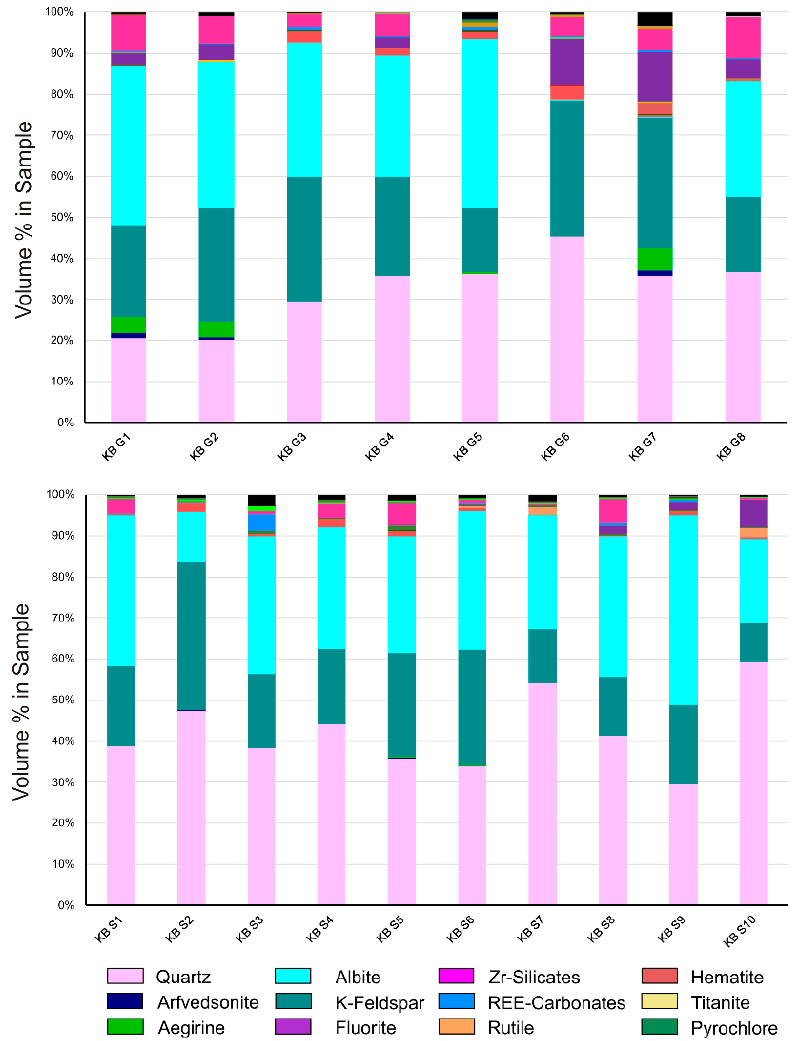
Figure 2. Modal composition (vol. %) of samples from ore bearing metasomatites in sampling areas KB G ( top ) and KB S ( bottom ), calculated from mineralogical phase maps.